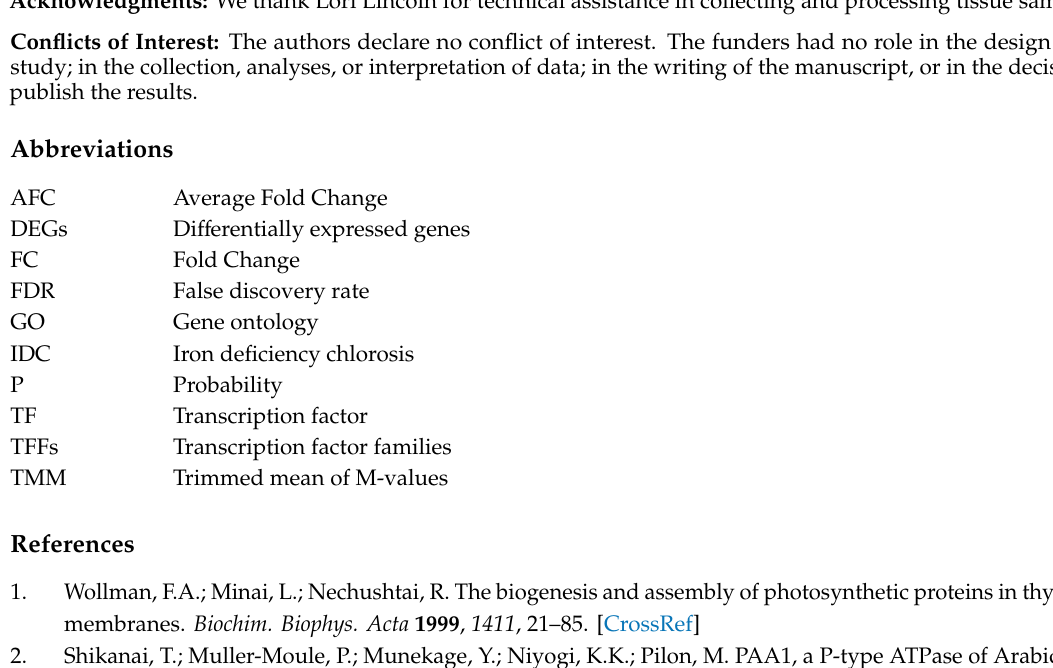
Table S7. Annotation and expression information for the leaf expression clusters L1-L4.; Table S8. Annotation and expression information for the root expression clusters R1-R4.; Table S9. Gene ontology (GO) biological process terms overrepresented in leaf DEG expression clusters (L1-L4); Table S10. Gene ontology (GO) biological